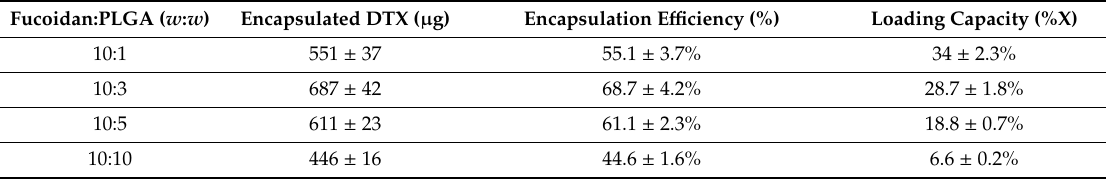
Table 2. Formulations and their corresponding encapsulated amounts, encapsulation e ffi ciency